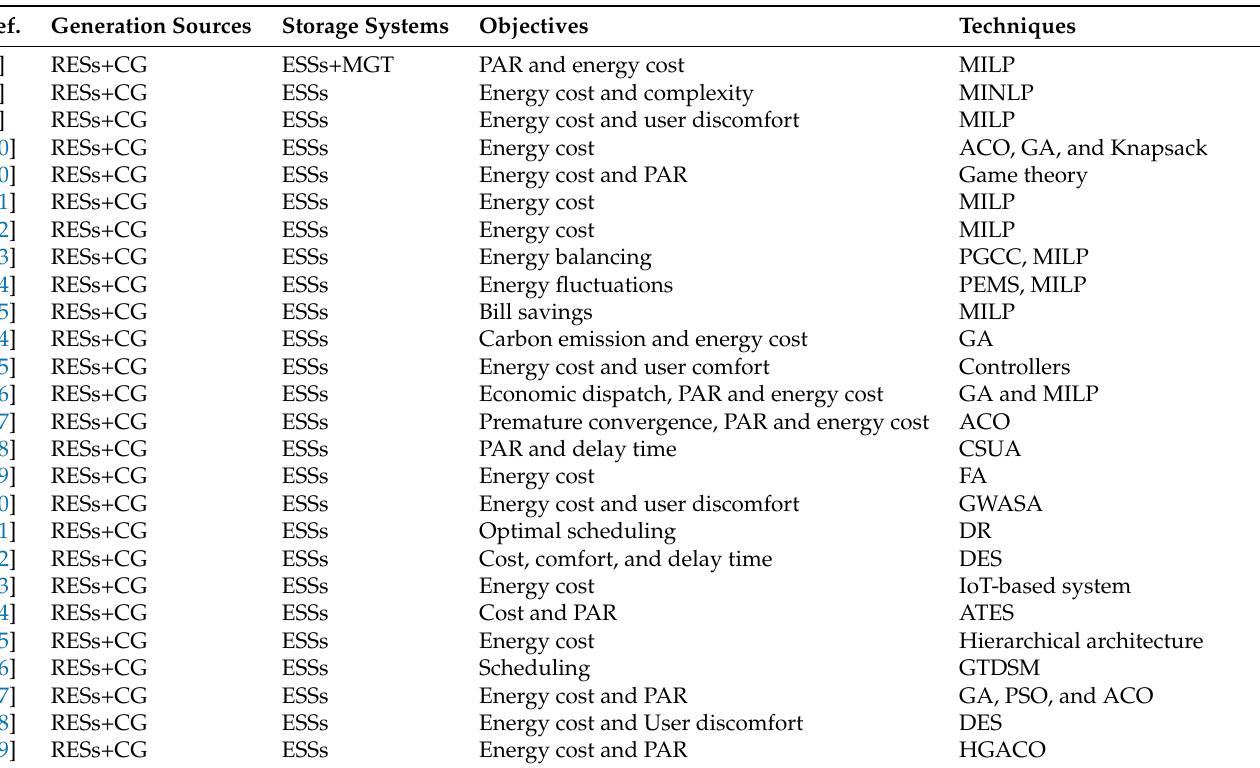
Table 1. Summary of related work in aspects of objectives, sources, algorithms, and storage systems, where RESs is Renewable Energy Sources, ESSs is Energy Storage Systems, CG is Commercial Grid, and MGT is Micro Gas